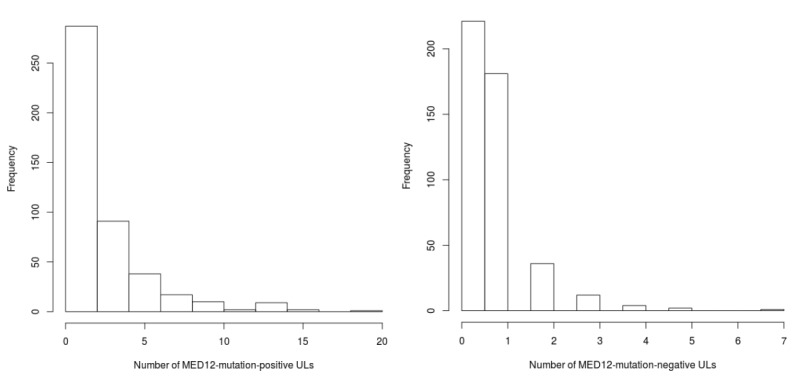
MED12 mutation status distributions for the Helsinki cohort patients.On left, mutation-positive tumors per patient (n = 457), and on right, mutation-negative tumors per patient (n = 457).